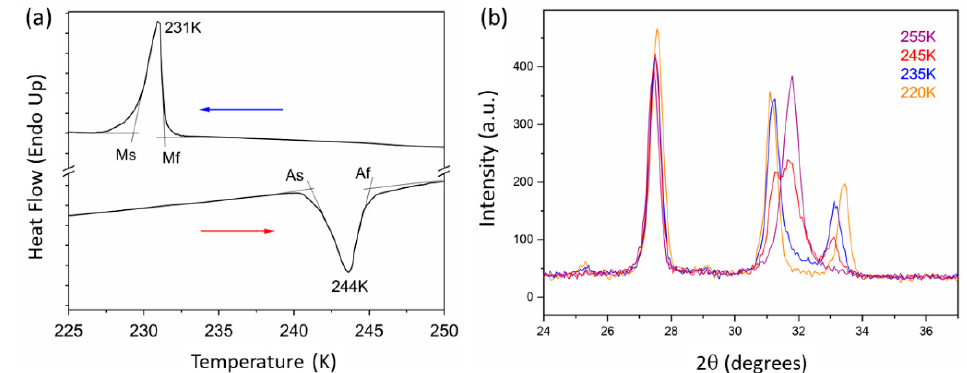
Figure 2. ( a ) DSC scan of the Ni 2.07 Mn 0.93 Ga sample (Ms = start of martensite, Mf = finish of martensite, As = start of austenite, Af = finish of austenite). ( b ) Neutron diffraction patterns in the 24–37° 2 θ range collected at different temperatures.